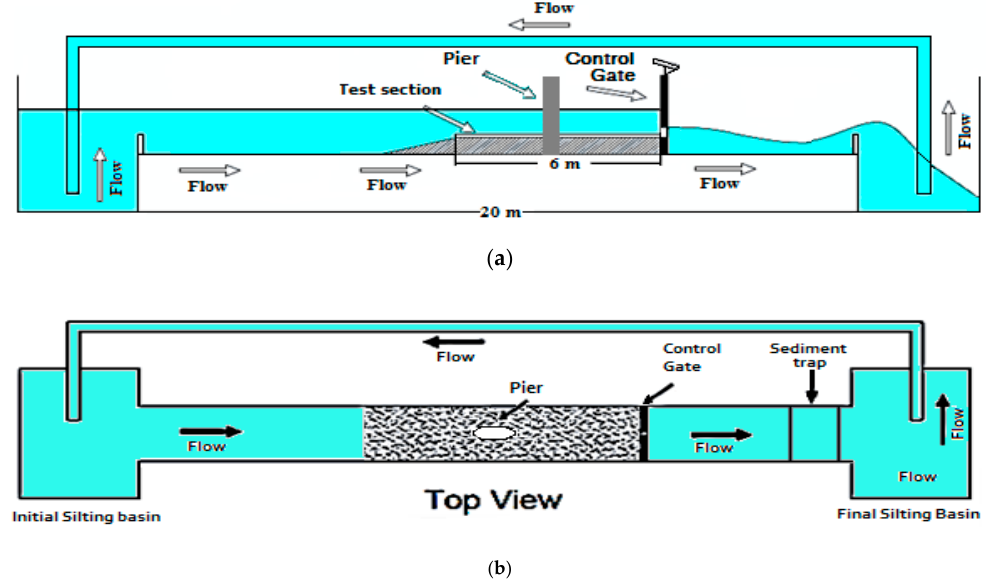
Figure 1. ( a ) Cross section of experimental rectangular flume, ( b ) Top view of experimental rectangular